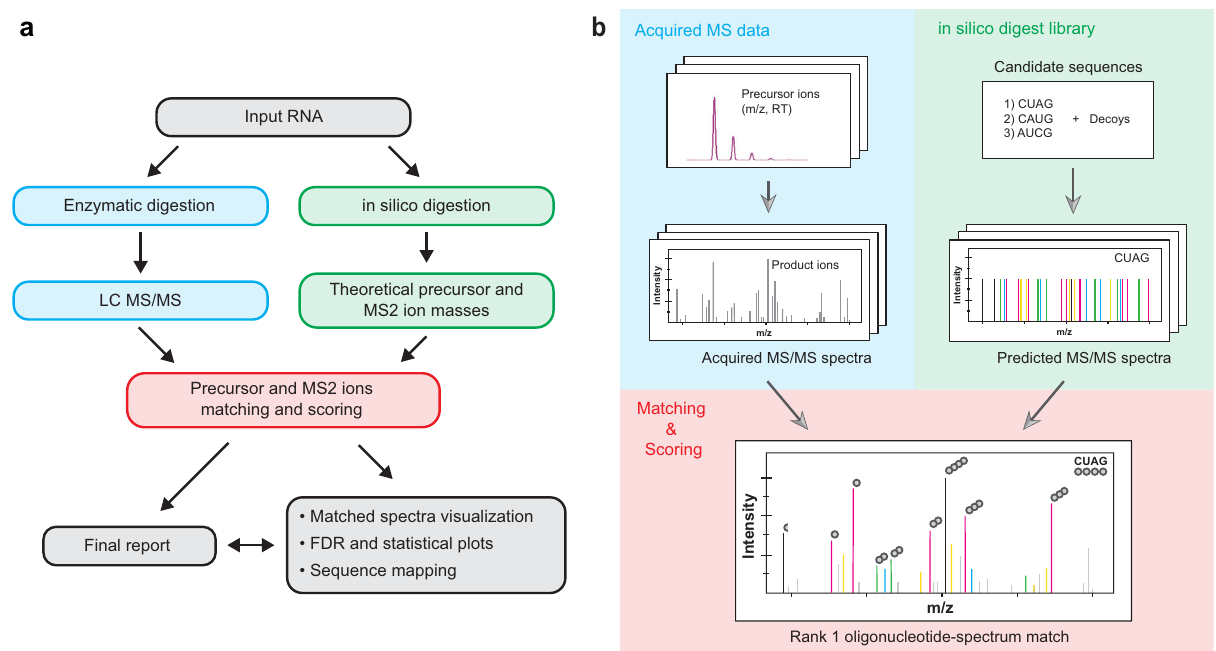
Fig. 1 RNA LC-MS/MS and Pytheas data analysis work fl ows. a Flowchart highlighting the main components of the Pytheas package. b Graphical overview of the database matching process. In both panels, blue shading refers to the experimental data acquisition, green shading refers to the in silico generated theoretical library and red shading refers to the matching and scoring steps.